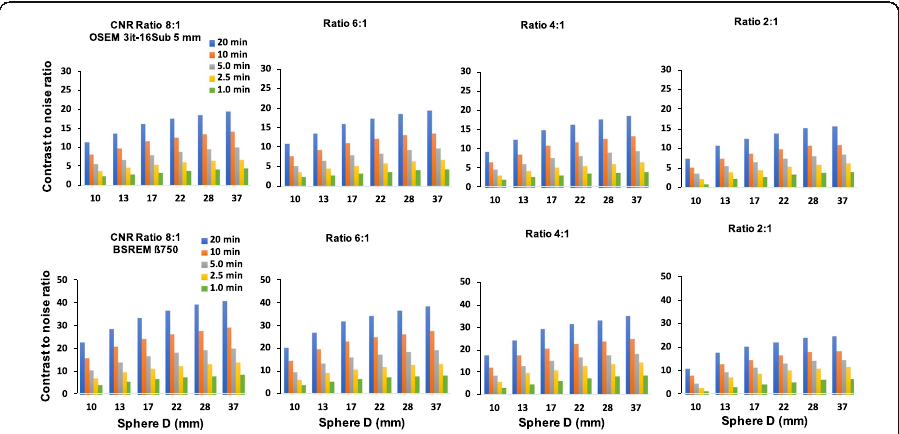
Fig. 4 Comparison in terms of CNR as a function of sphere size between (top) TOF-OSEM (3 iterations, 16 subsets, post-filter 5.0 mm and PSF) and (Bottom) BSREM with β = 750 (including TOF and PSF) for different count statistics and contrast ratios. Note that the maximum scale value showed in the graphs are different between both